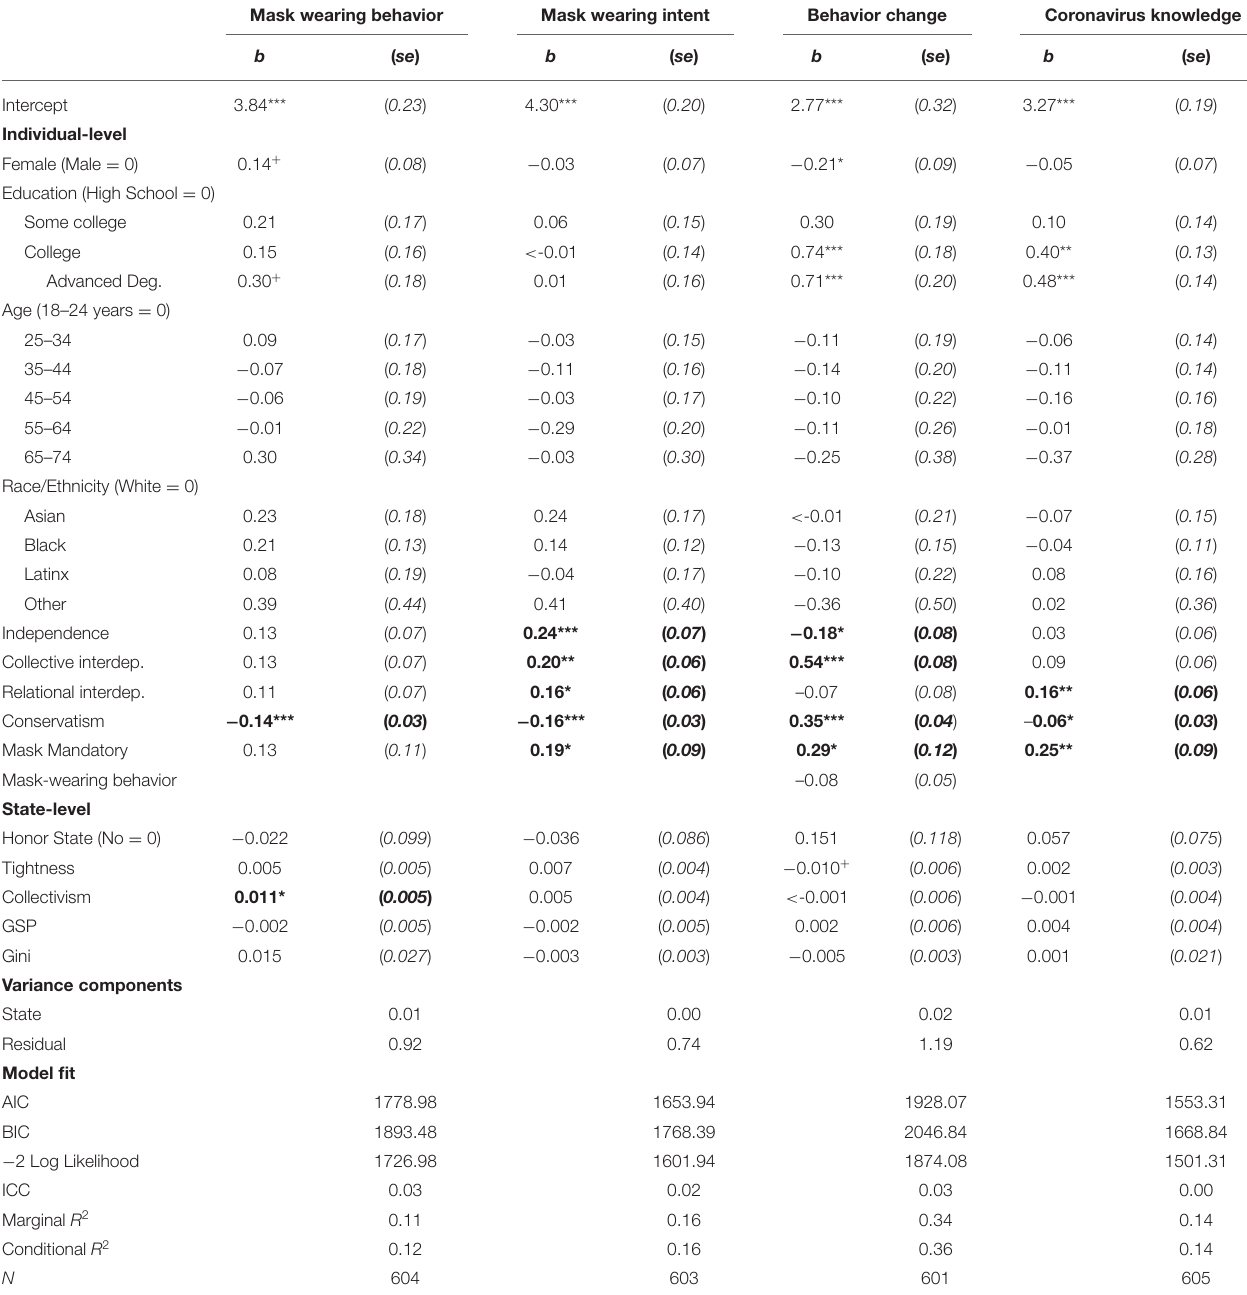
TABLE 3 | Result of multilevel analyses: mask-wearing behaviors, behavior change, and knowledge. Mask wearing behavior Mask wearing intent Behavior change Coronavirus